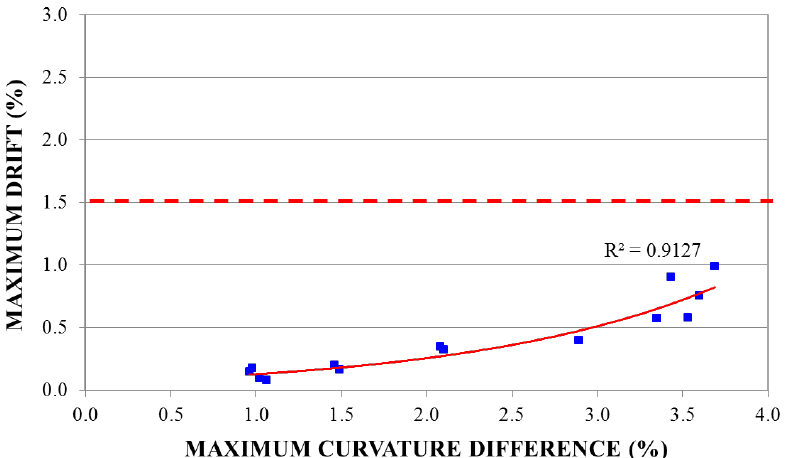
Figure 16. Structural damage quantification: empirical correlation between the maximum inter-story drift and the maximum curvature difference for the 5-story building with infill panels.